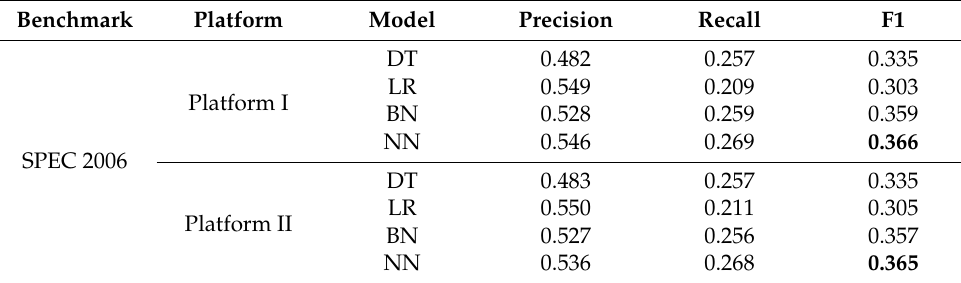
Table 4. Predictive results of different machine learning